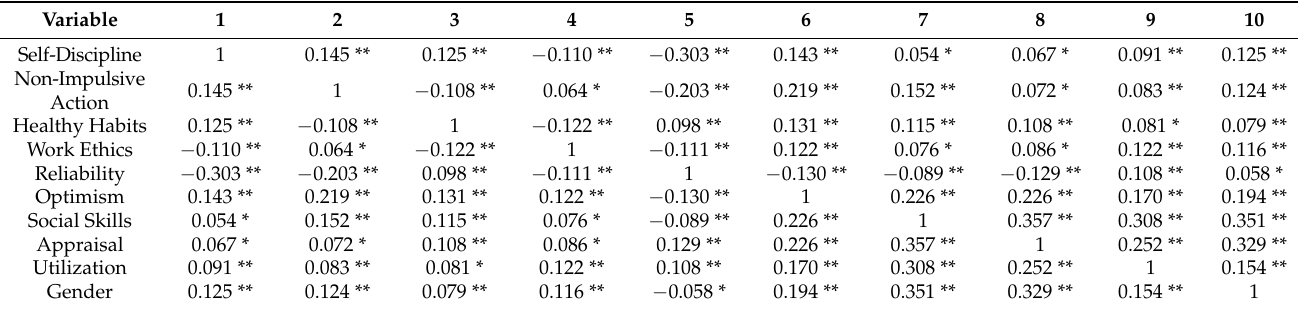
Table 2. Pearson correlations coefficients amongst emotional intelligence, self-control components, and gender.